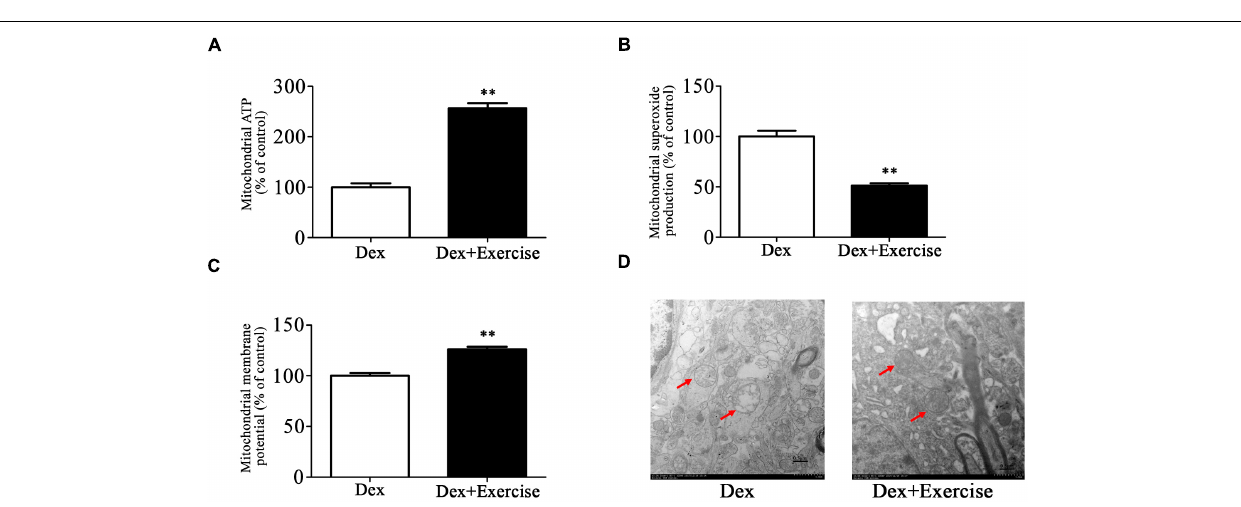
FIGURE 6 | Effects of treadmill exercise on mitochondrial function and morphology in Dex offspring. Dex offspring at 4-week old received 4 weeks of treadmill exercise. Then, mitochondria were isolated from hippocampus for the determination of ATP production (A) , mitochondrial superoxide production (B) , and membrane potential (C) as described in Section “Materials and Methods”. Mitochondrial morphology (D) was determined by transmission electron microscopy. Data are presented as means ± SEM ( n = 10/group). ∗∗ P < 0.01 vs. Dex. Dex,